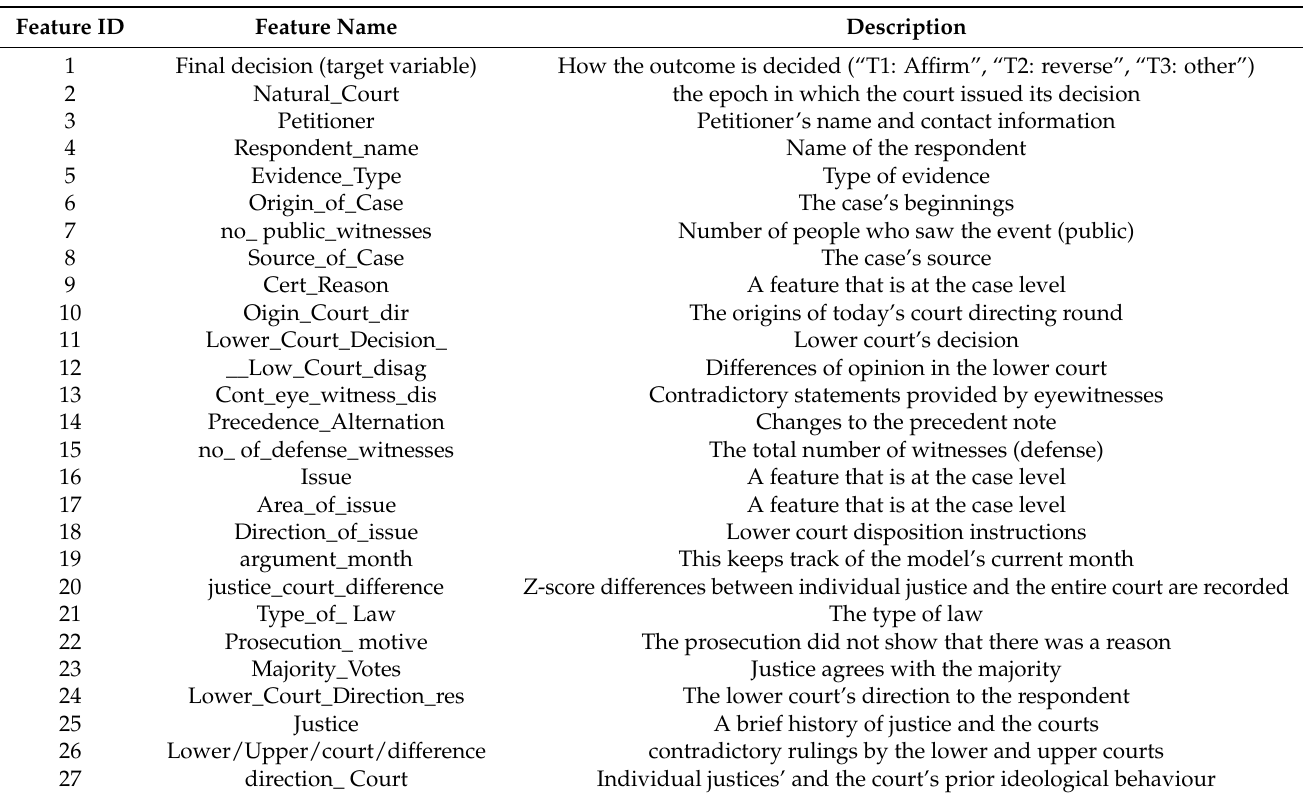
Table 2. A list of features without feature selection that can be used to make predictions about the judgement of a court